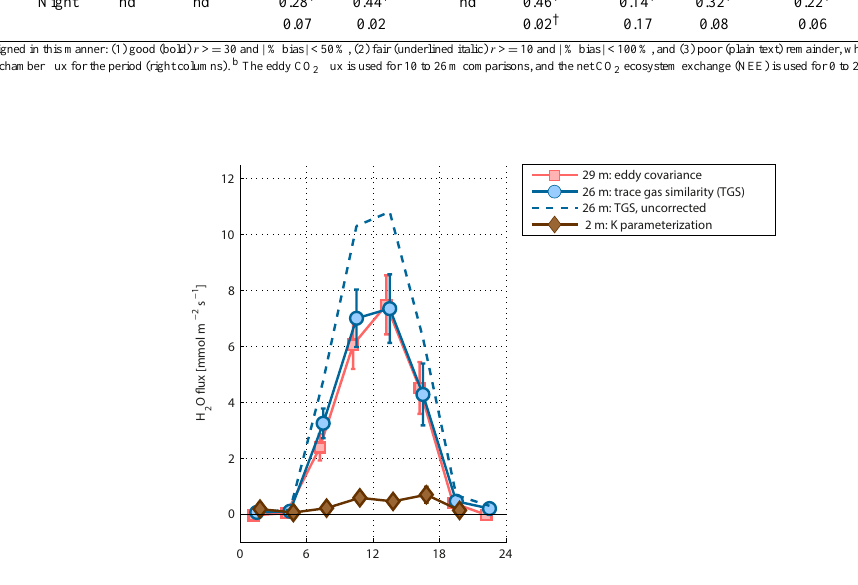
Figure A1. Comparison of summertime H 2 O fluxes (15–22 July 2011 period) throughout the forest canopy: eddy covariance, trace gas similarity via CO 2 (corrected and uncorrected; Sect. 4.2), and K parameterization. Data points represent 3h aggregate mean and 95% confidence